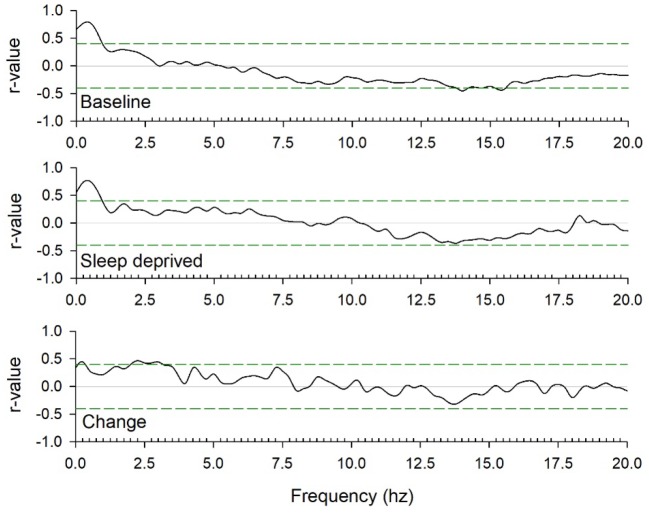
Spearman rank correlation coefficients between global mGluR5 availability and EEG power between 0 and 20 Hz in baseline and sleep deprivation conditions, and the change caused by sleep loss.The green lines indicate r-values that are above (or below) the α < 0.05 significance threshold.